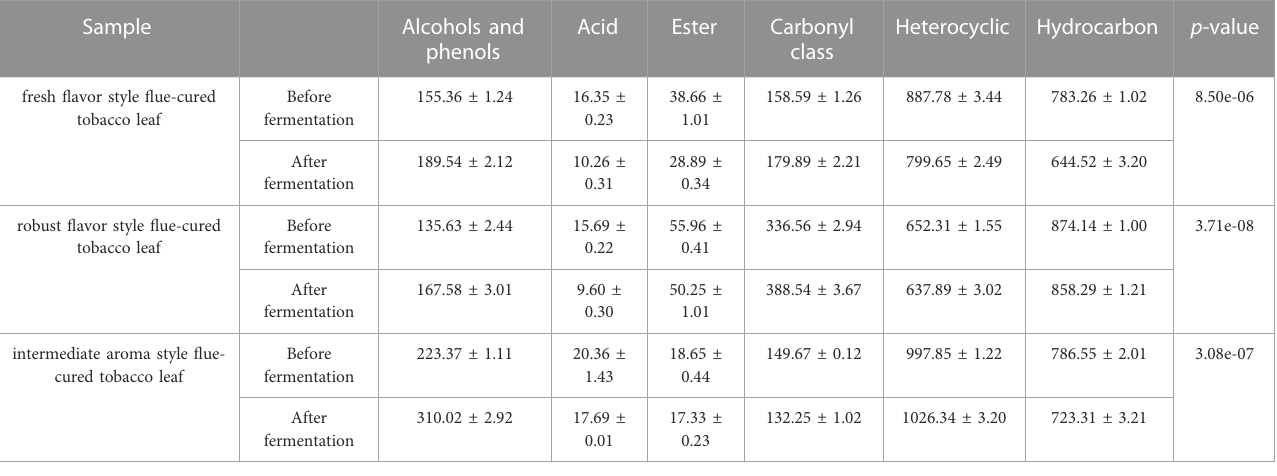
TABLE 4 Changes of volatile components in tobacco leaves treated by strain 3# (ug/g). Sample Alcohols and phenols